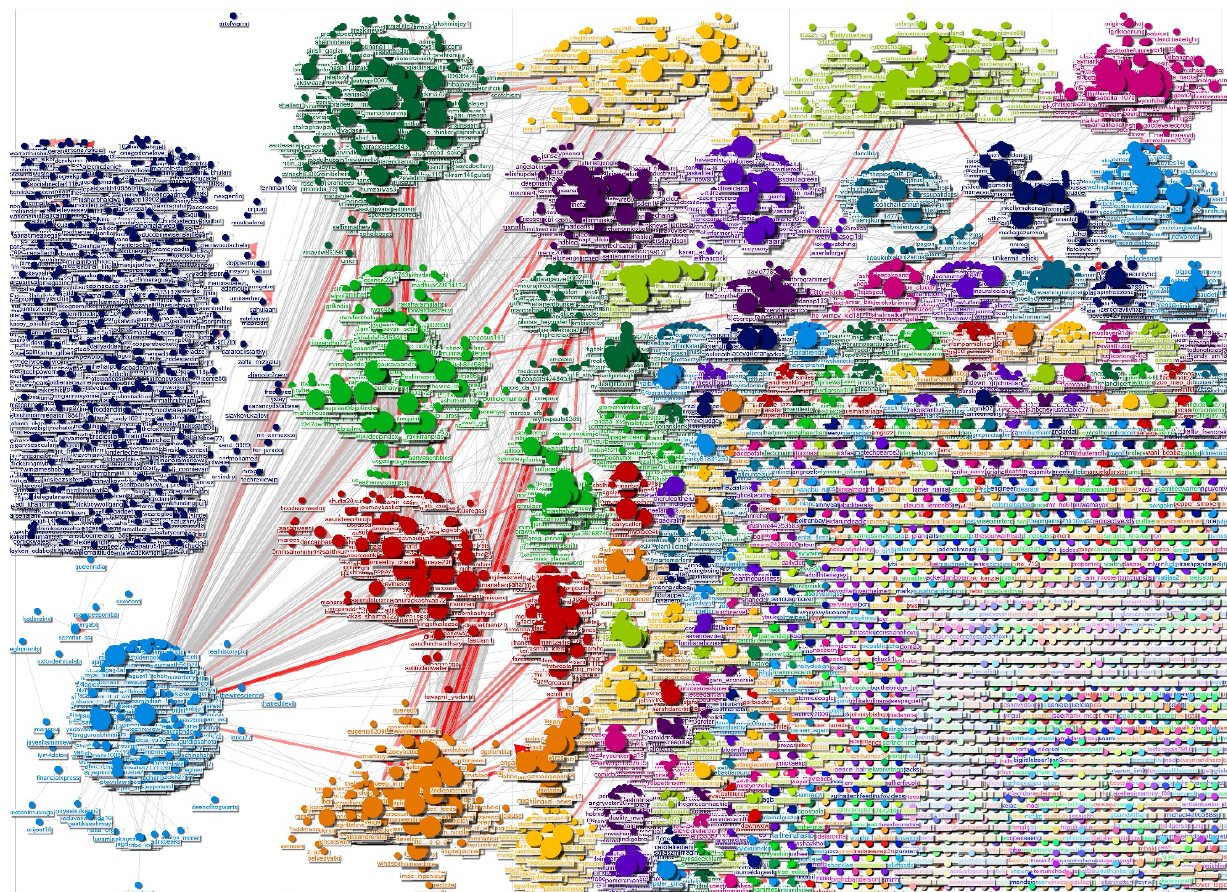
Figure 1. Illustration of the network around the term